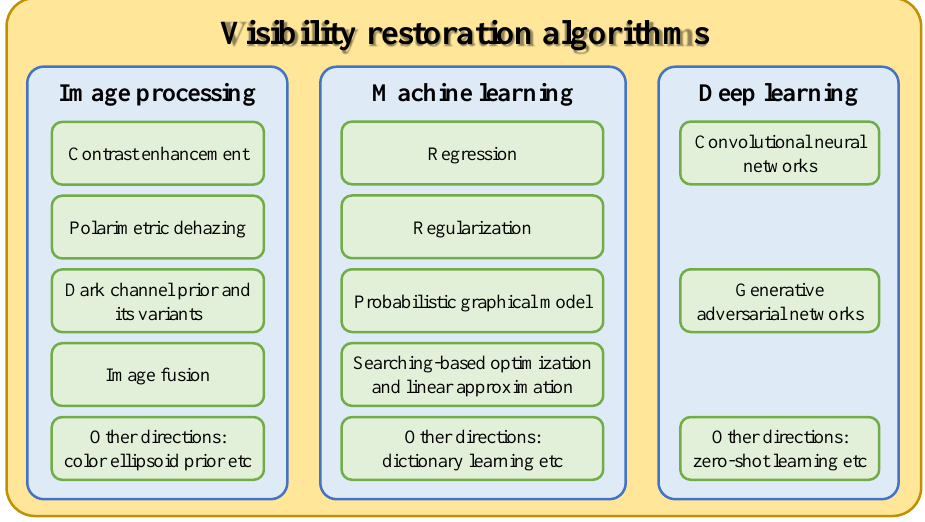
Figure 4. General classification of visibility restoration